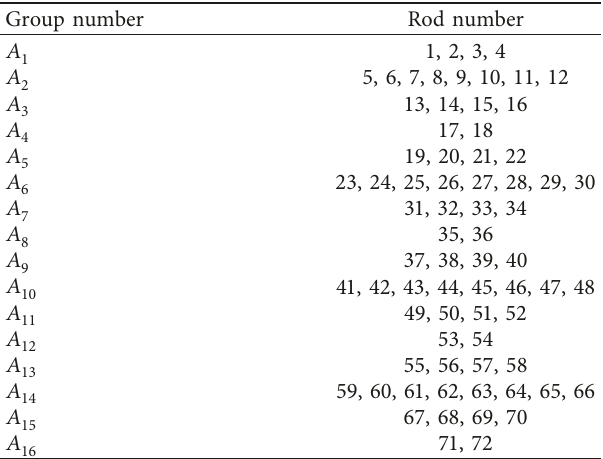
Figure 11: Schematic diagram of the 72bar space truss structure. Table 9: 72bar space truss load. Table 10: 72bar space truss